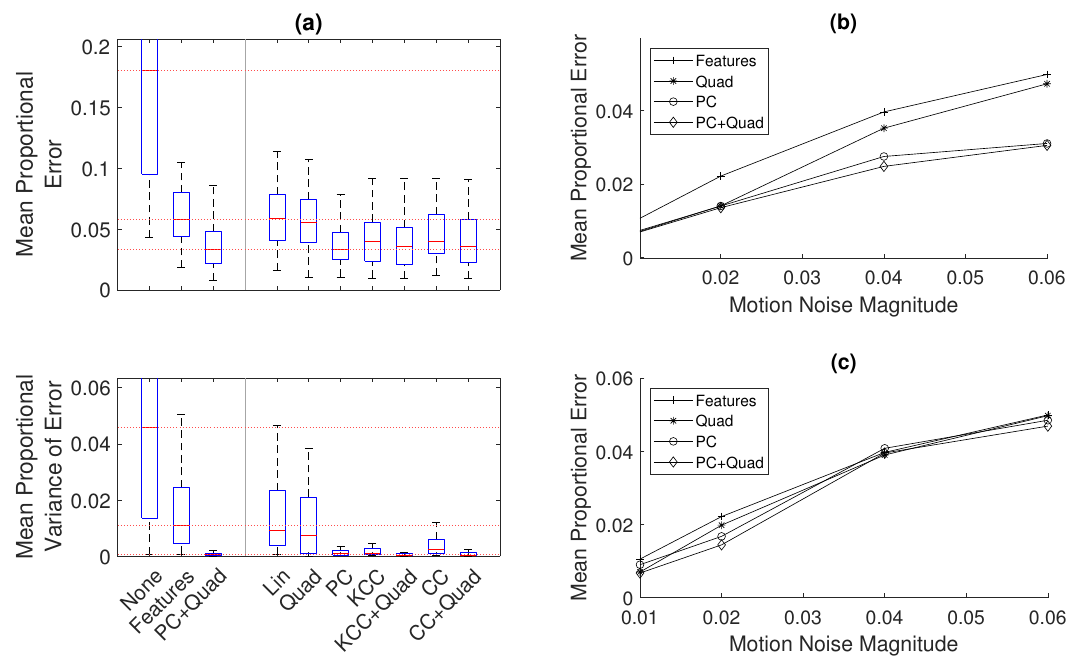
Figure 7. A comparison of methods used to improve the trajectory estimate in a single 1D pipe: in all cases, proportional measures of error are used, which are normalized by the length of the pipe, to more easily allow comparison to other results. ( a ) A comparison of the benchmark pipe-feature method with the different developed spatial field information methods in the 5-m pipe for a motion noise magnitude of 0.06 of the command motion, using box plots to show the quartiles of results over 50 sets of random noise: the top graph shows the error in the estimation, and the bottom graph shows the inconsistency in the estimation. On the left is the unoptimized ( None ), benchmark ( Features ), and improved estimate ( PC+Quad ) results. On the right is the results found using the other methods presented in this paper. ( b , c ) The median accuracy for each of the methods for the 5- and 20-m pipes respectively, over a range of noise magnitudes: the variance of the normally distributed noise added to the motion at each time step is equal to the noise magnitude multiplied by the command